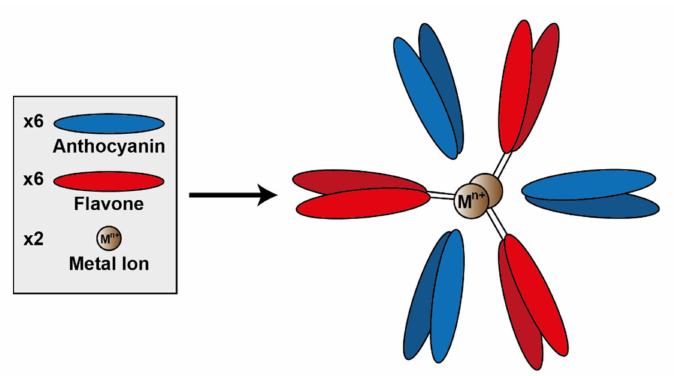
Figure 14. Assembly of metalloanthocyanin complex by self-assembly of six anthocyanin molecules, six flavone molecules, and two metal cations. Adapted from